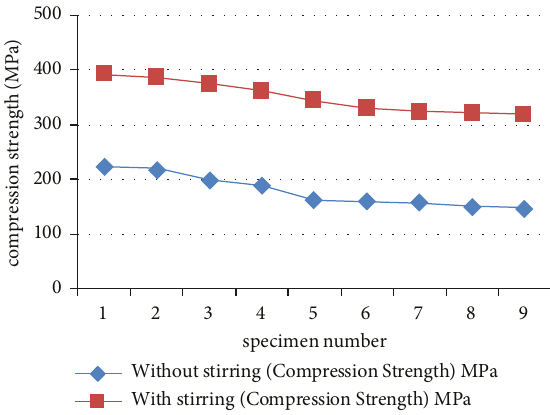
Figure 25: Graph for compression strength for different specimens.